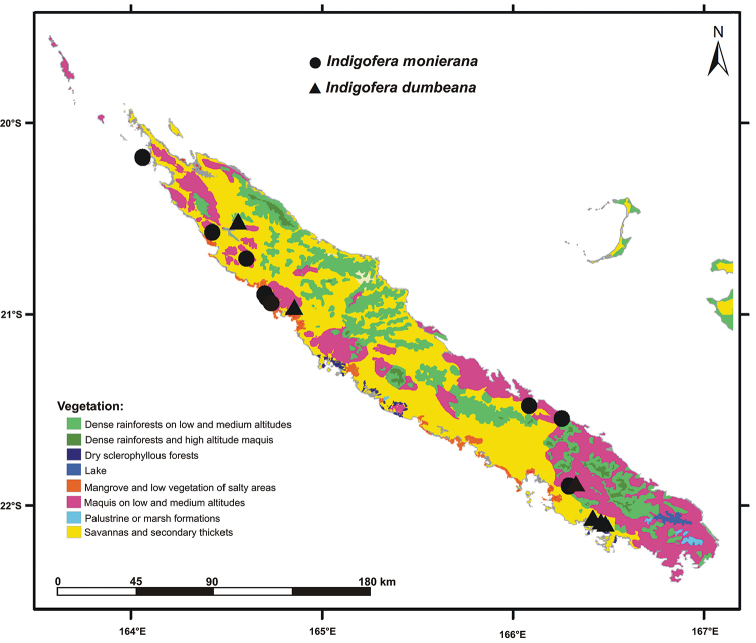
Map of the New Caledonia archipelago showing the major vegetation types (from Jaffré et al. 2012) and the distribution of the new species Indigoferamonieriana and I.dumbeana.